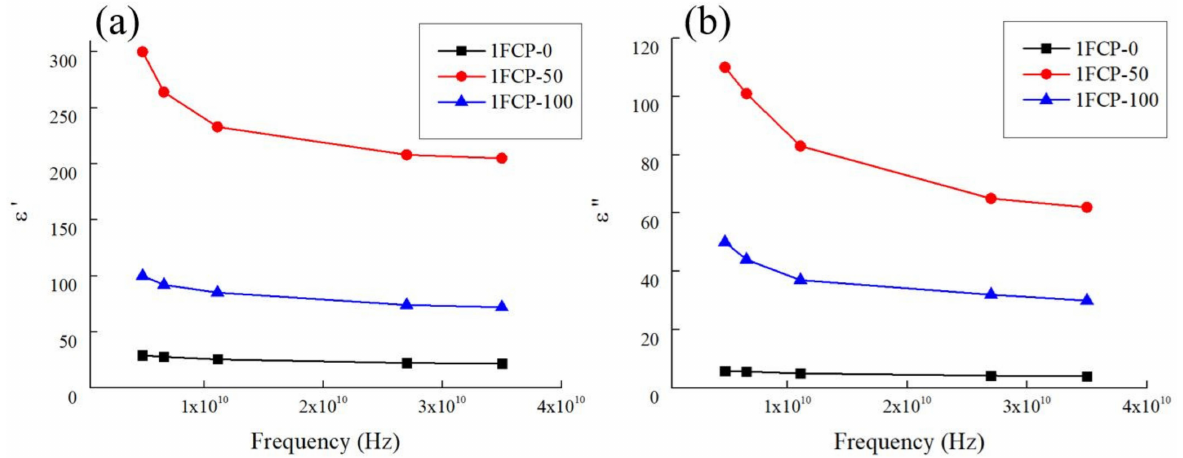
Figure 5. Experimental frequency dependences of the real ( a ) and imaginary ( b ) parts of the complex permittivity for the samples 1FPC-0 containing only 1 wt% rGO, 1FPC-50 containing a mixture of 0.5 wt% SWCNTs and 0.5 wt% rGO, 1FPC-100 containing only 1 wt%